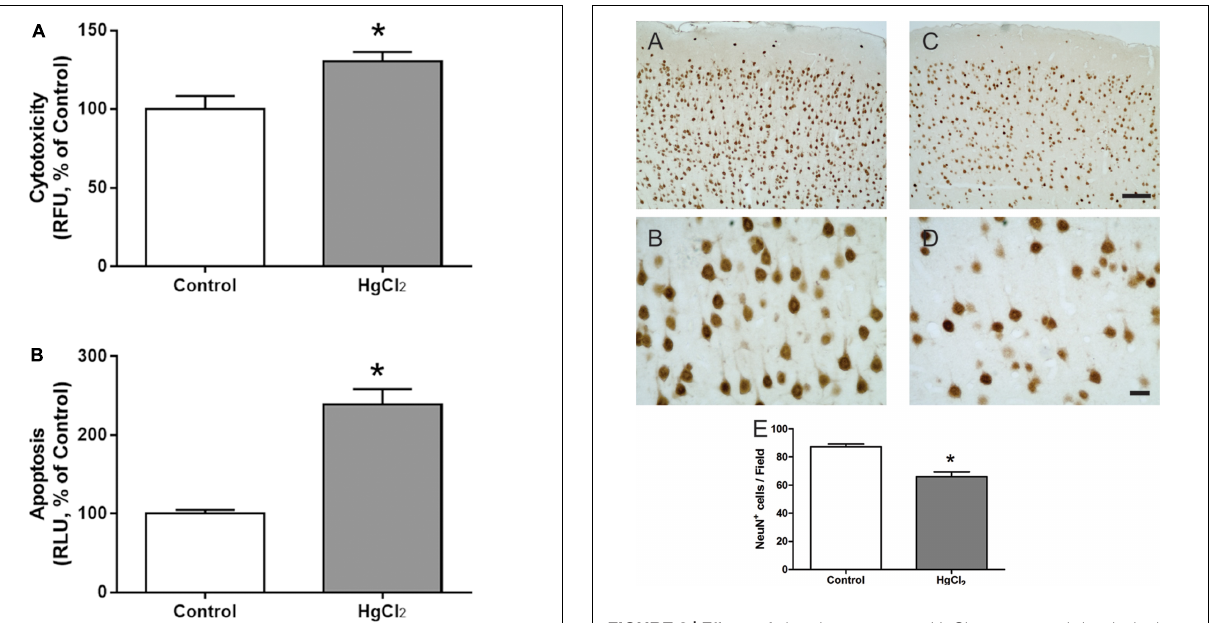
FIGURE 8 | Effects of chronic exposure to HgCl 2 on neuronal density in the motor cortex of adult Wistar rats. (A–D) represent photomicrographs of the NeuN-labeled motor cortex of the control animals (A,B) and the exposed animals (C,D) . The results are expressed as mean ± standard error of the number of cells counted per field (E) . ∗ p < 0.05 compared to the control group (Student’s t -test). Scale bar (A,C) 100 µ m; (B,D) 20 µ